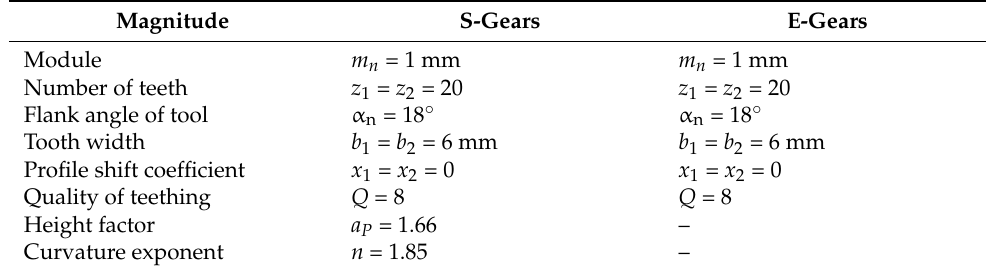
Table 2. Main geometrical data of tested gears.